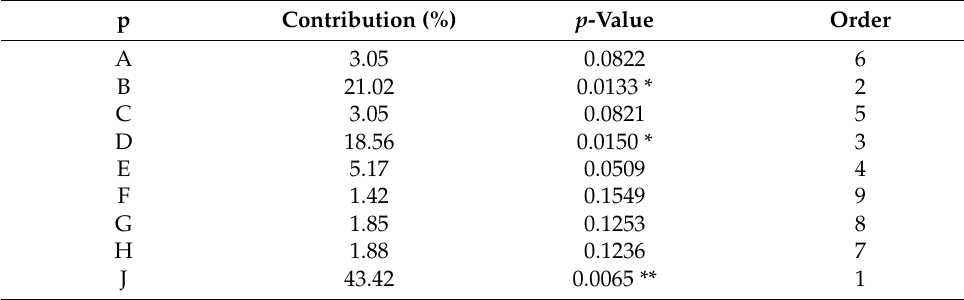
Table 3. Significance analysis of parameters in PB test.